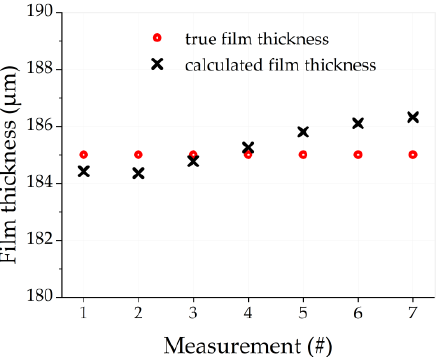
Figure 11. Film thickness of test set. Red circles: true, predefined film thickness. Black crosses: calculated film thickness with calibration at ν 1 = 4253 cm − 1 .